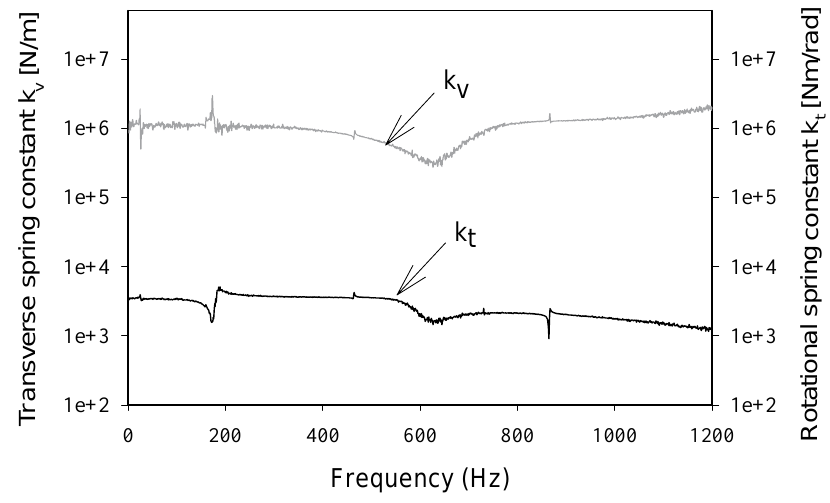
Fig. 9. Predicted equivalent transverse and torsional spring constants for the equivalent bolt-joint model.